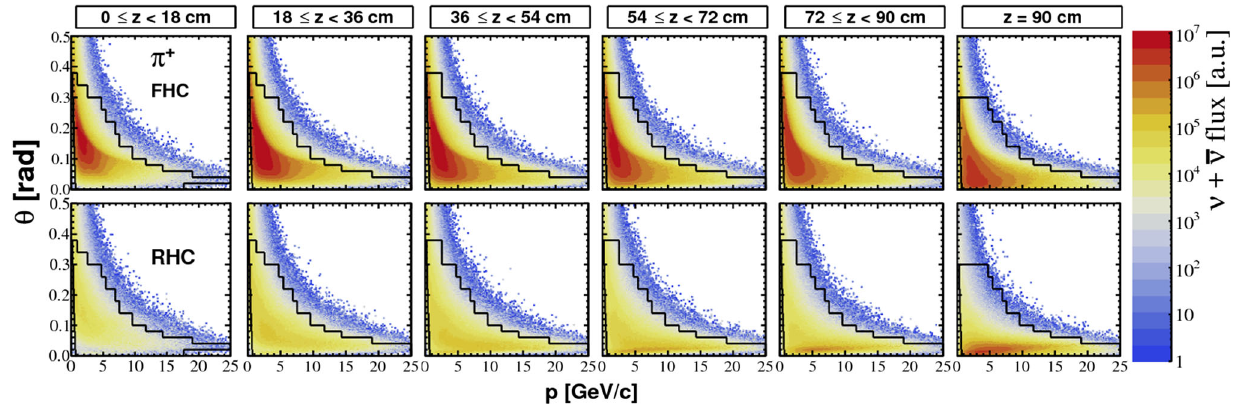
Fig. 7 The p − θ distribution of positively charged pions emitted from the surface of the T2K target which contribute to the (anti)neutrino flux in Super-Kamiokande . The top row shows the phase space plots in the forward horn current configuration, while bottom plots show the phase